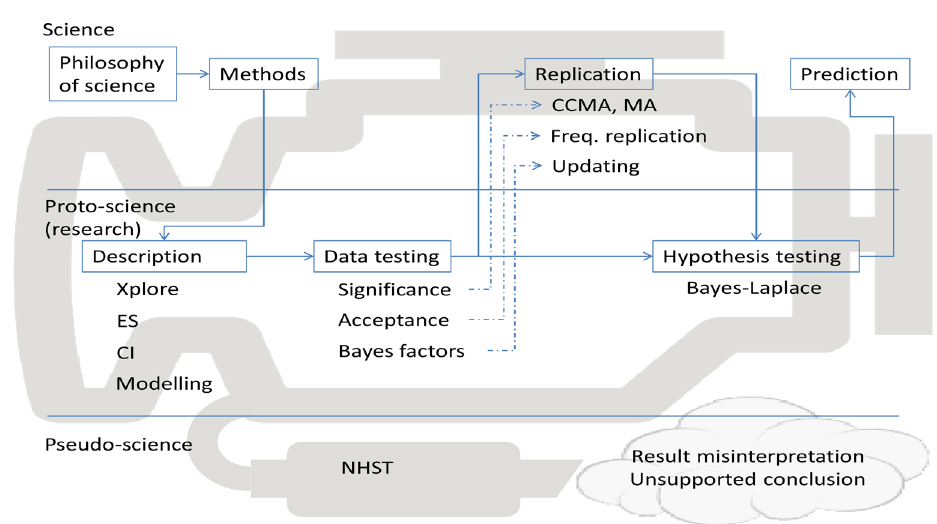
Figure 1. The engine of science (conceptual illustration). Xplore = exploratory data analysis; ES = effect size; CI = confidence interval, credible interval; CCMA = continuous cumulating meta-analysis; MA = meta-analysis; Freq. replication = frequentist replication; NHST = null hypothesis significance testing (as in Perezgonzalez,